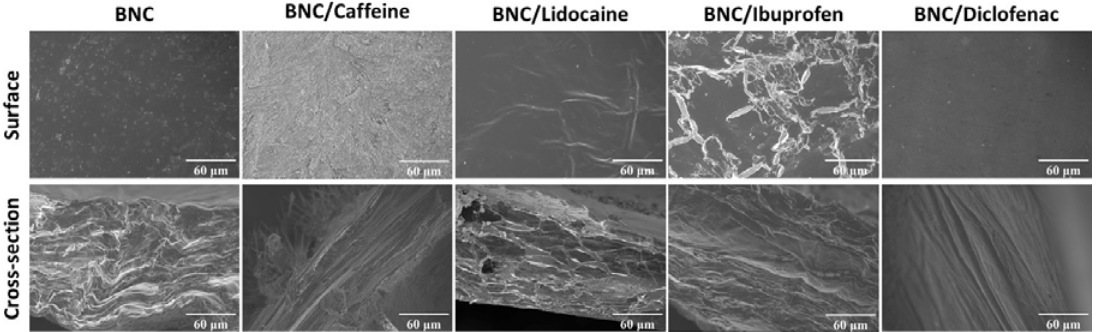
Figure 2 . SEM micrographs of the surface and cross ‐ section of the plasticized BNC and API ‐ loaded BNC